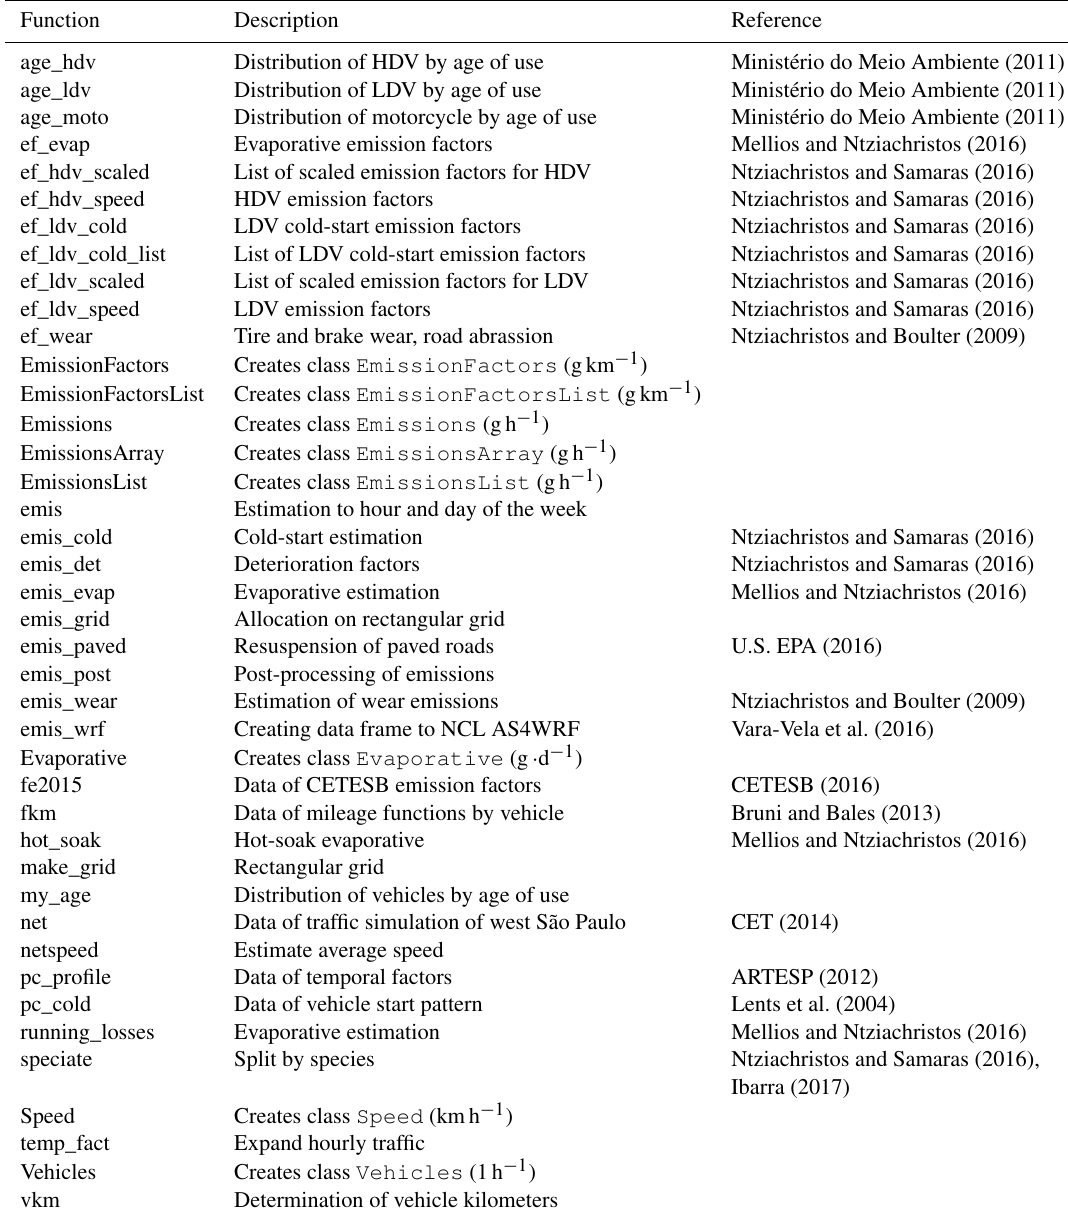
Table 1. Summary of the VEIN classes, functions and internal